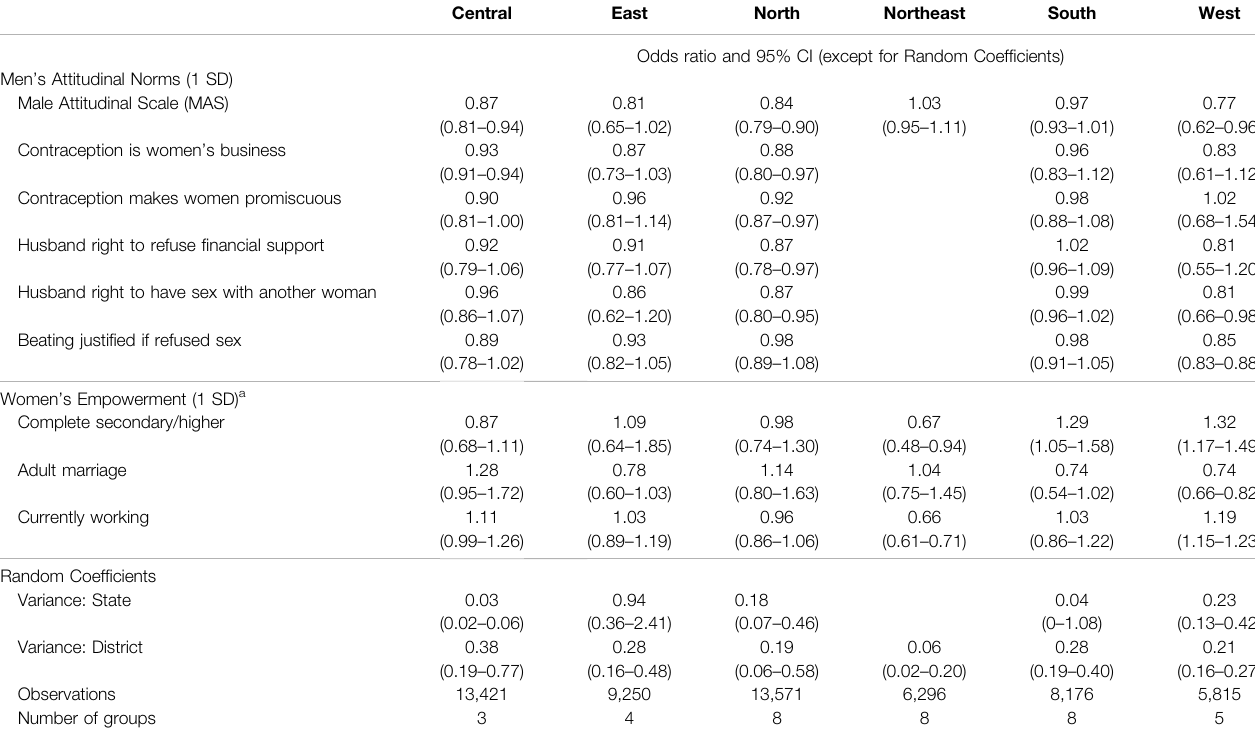
TABLE 4 | Multilevel associations of attitudinal and empowerment norms and demand satis fi ed for contraception, by Indian Region (NFHS-4). Central East